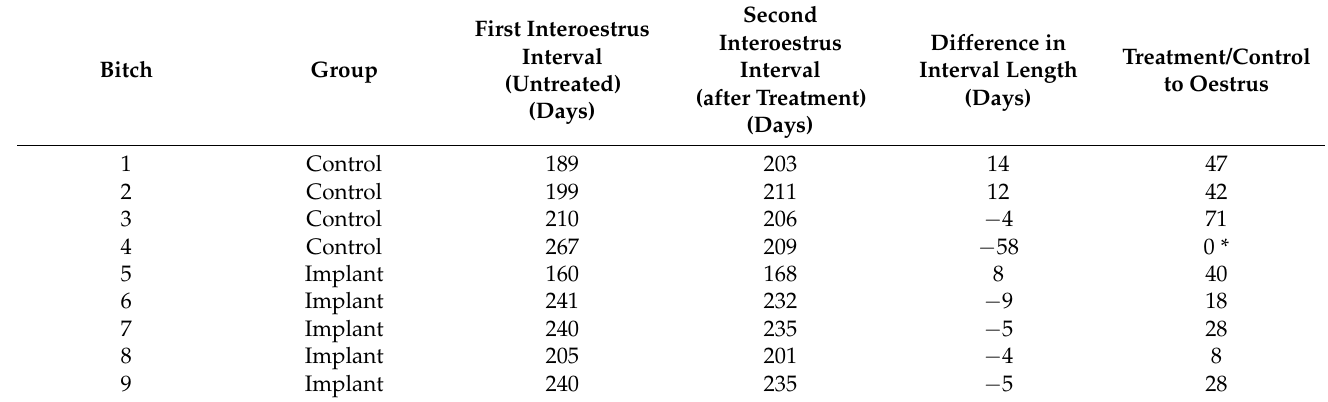
Table 1. Interoestrus intervals and time to pro-oestrus after treatment in individual bitches.